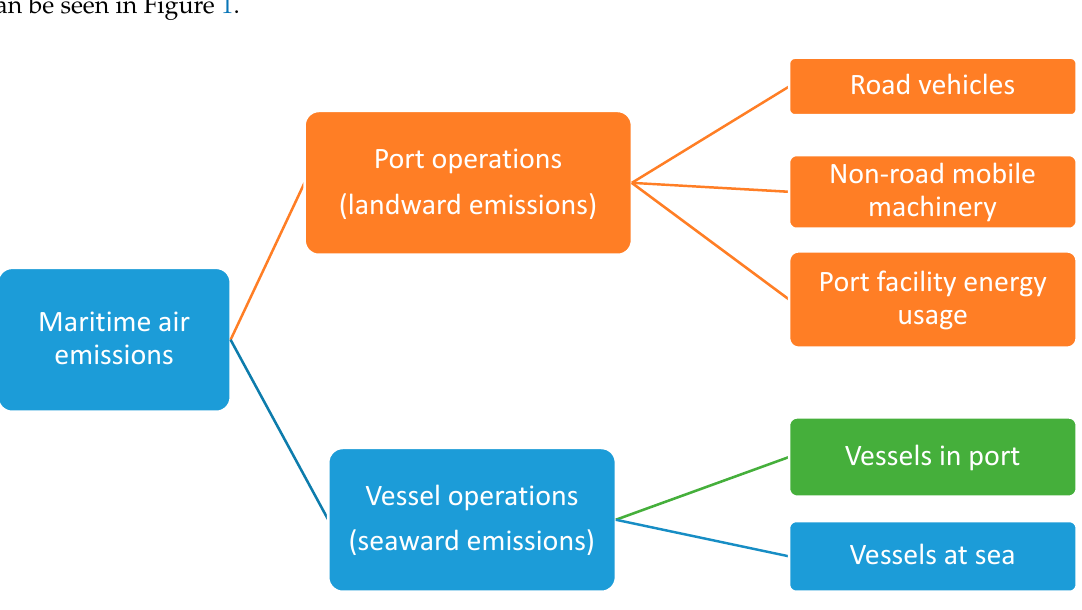
Figure 1. Sources of maritime air pollution.